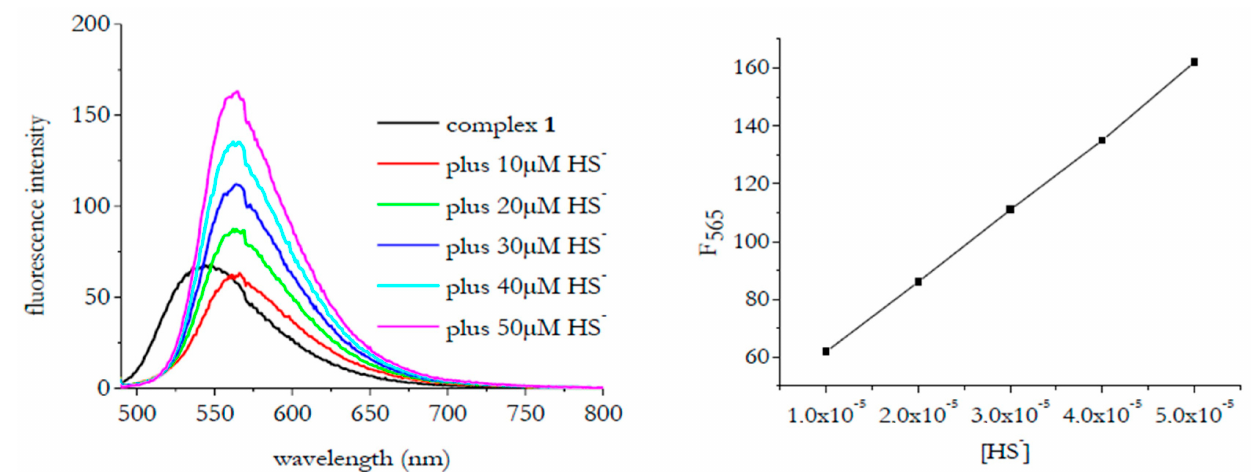
Figure 4. ( Left ) Emission spectra of complex 1 ( λ exc = 481 nm) when titrated with NaSH. [Complex 1 ] = 1 × 10 − 5 M; end concentration of NaSH varied in the range (1 − 5) × 10 − 5 M. ( Right ) The fluorescence intensity values of complex 1 at 565 nm have been plotted as a function of the HS − concentration.